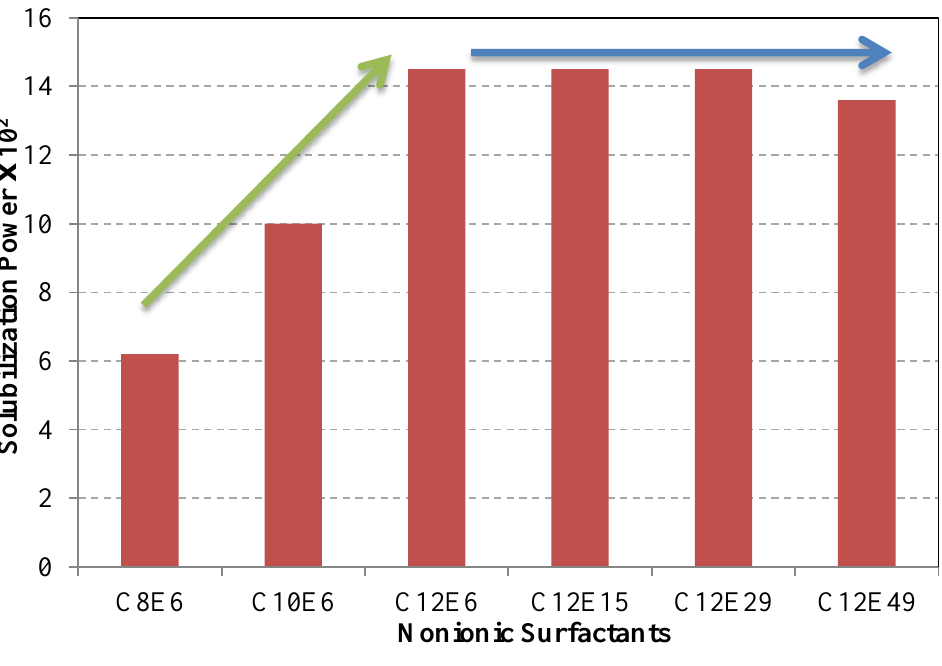
Figure 8. Amount of solubilized C.I. Solvent Yellow 6 (Yellow OB) as a function of the concentration of different surfactants. C sodium dodecyl sulfate. SDS can also be written C The measurements were made at 25  C. Data from